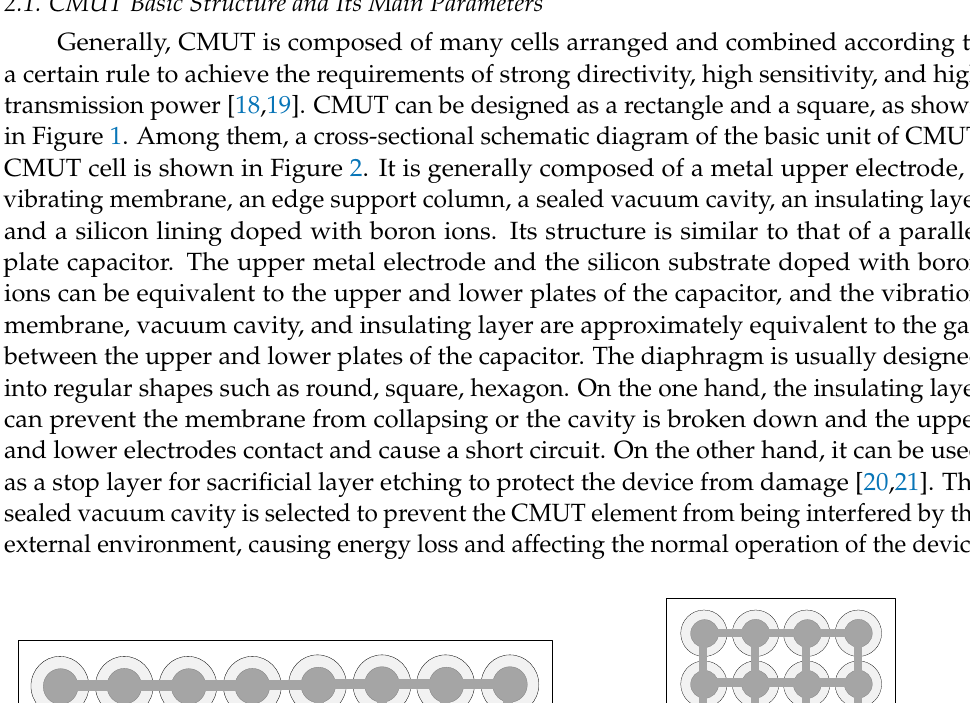
Si Figure 2. Schematic diagram of CMUT cell cross-section. The primary consideration in CMUT design is the resonance frequency. When the frequency of the applied excitation signal is equal to the resonance frequency of the trans- ducer, the vibrating membrane resonates and obtains a larger displacement. At this time, the CMUT obtains a larger emission sound pressure and receiving sensitivity, and the conversion efficiency reaches the best. The first-order resonance frequency of the circular vibrating membrane CMUT fixed around the periphery is [22]: